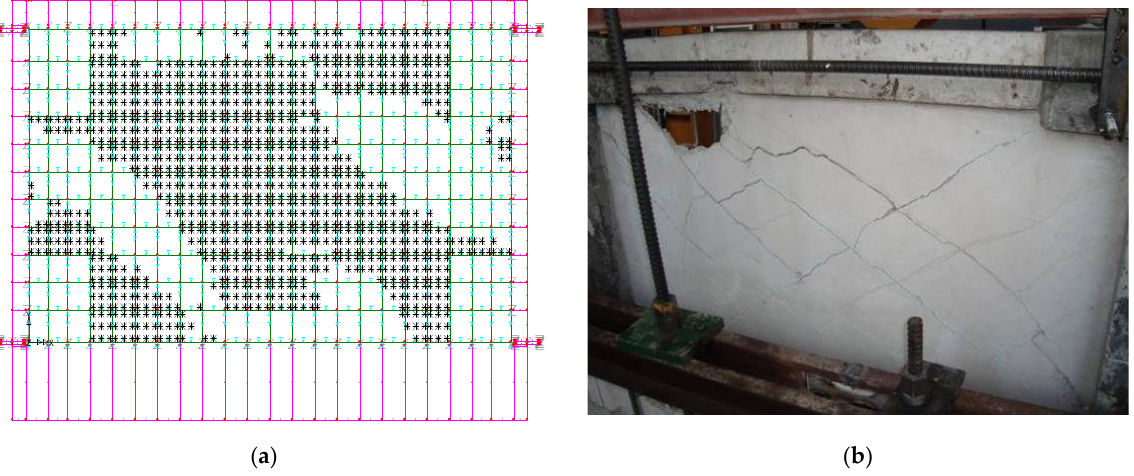
Figure 25. ( a ) The numerically predicted diagonal tension limit state for specimen UC ‐ IP 2. ( b ) The observed damage for specimen UC ‐ IP 2. Specimen RC-IP3: RC frame with Rein. Con. infill panel